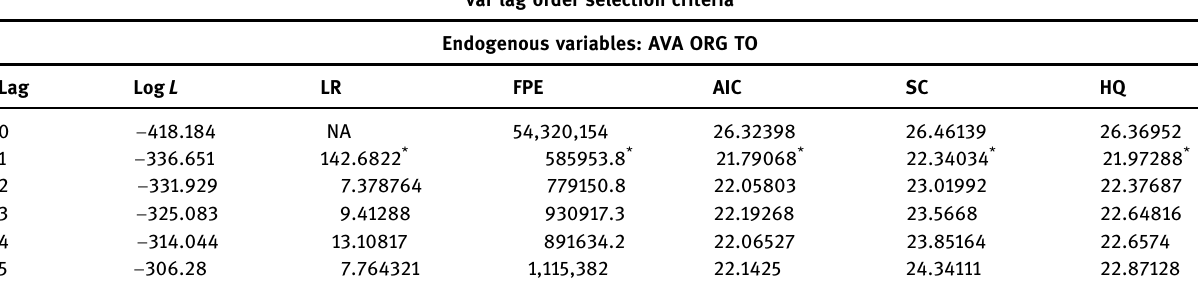
var lag order selection criteria Endogenous variables: AVA ORG